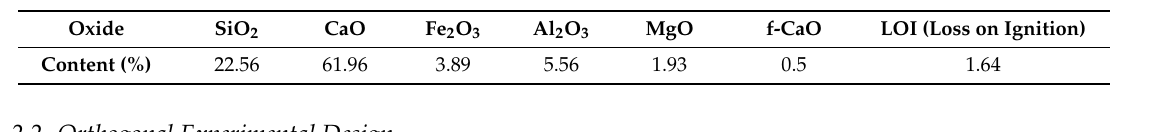
Table 1. Main oxide compositions of cement.